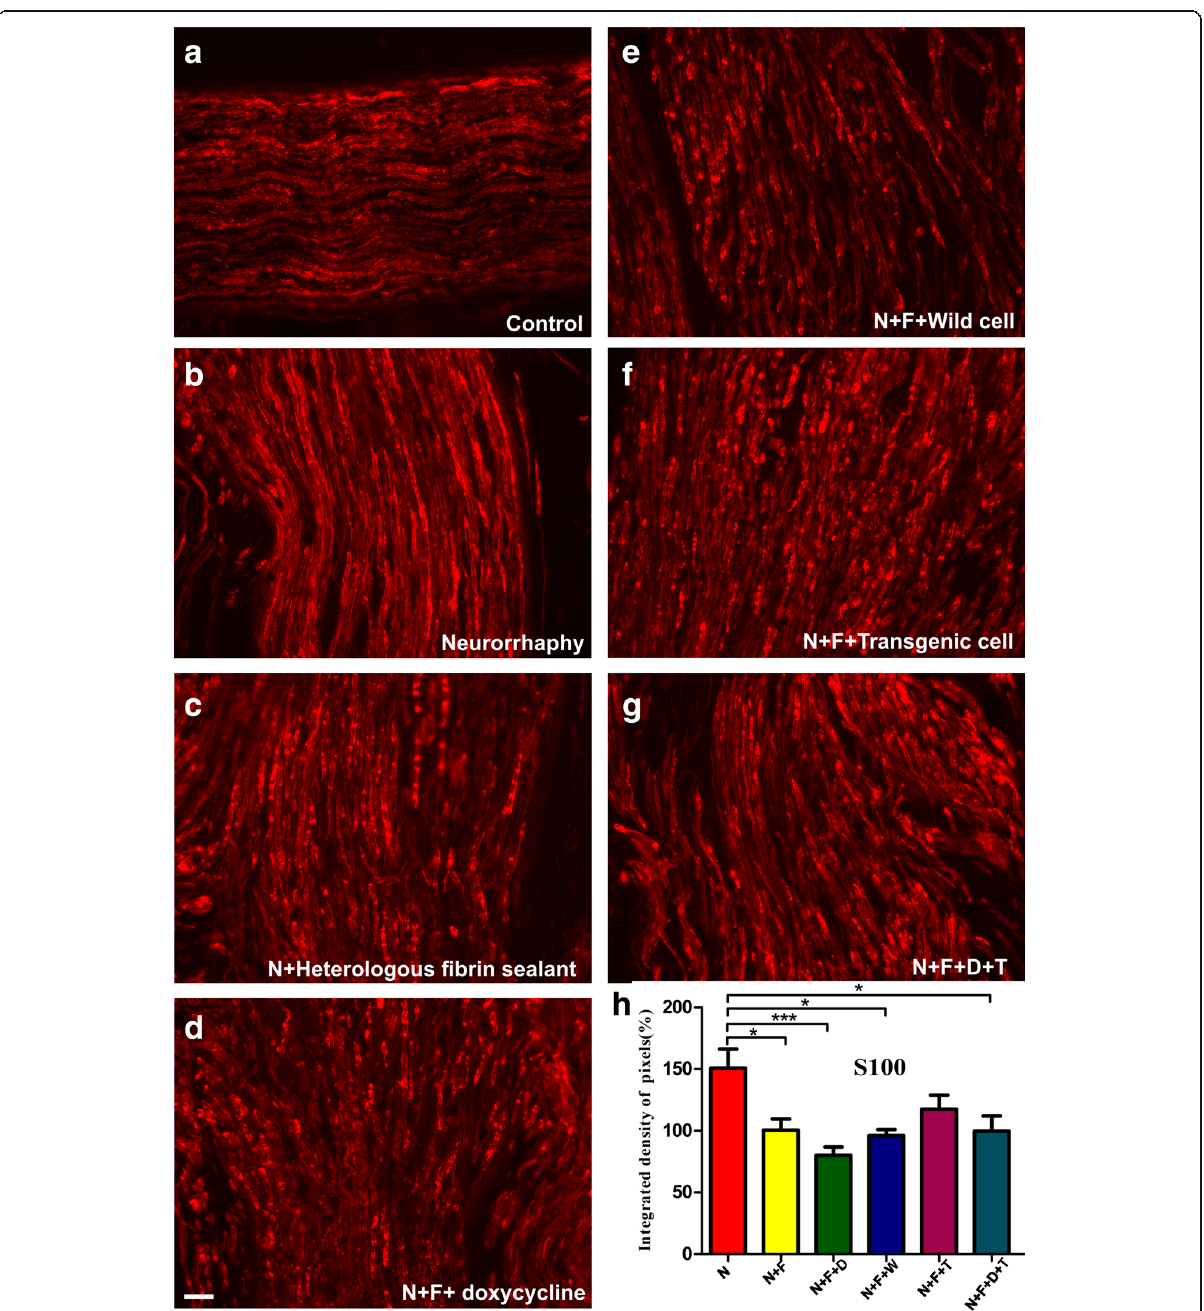
Fig. 6 Anti-S100 immuno-staining of ( a ) the control nerves and ( b to g ) all groups, 60 days after surgery. h Quantification of the integrated density of pixels in the experimental groups relative to control group (%). Statistically, the difference between the following groups are meaningful: N versus N+F ( p <0.05), N versus N+F+D ( p <0.001), N versus N+F+W ( p <0.05), and N versus N+F+D+T ( p <0.05). The N versus N+F+T shows no significant difference. Scale bar: 50 μ m. N: neurorrhaphy, F: heterologous fibrin sealant, D: doxycycline, T: transgenic